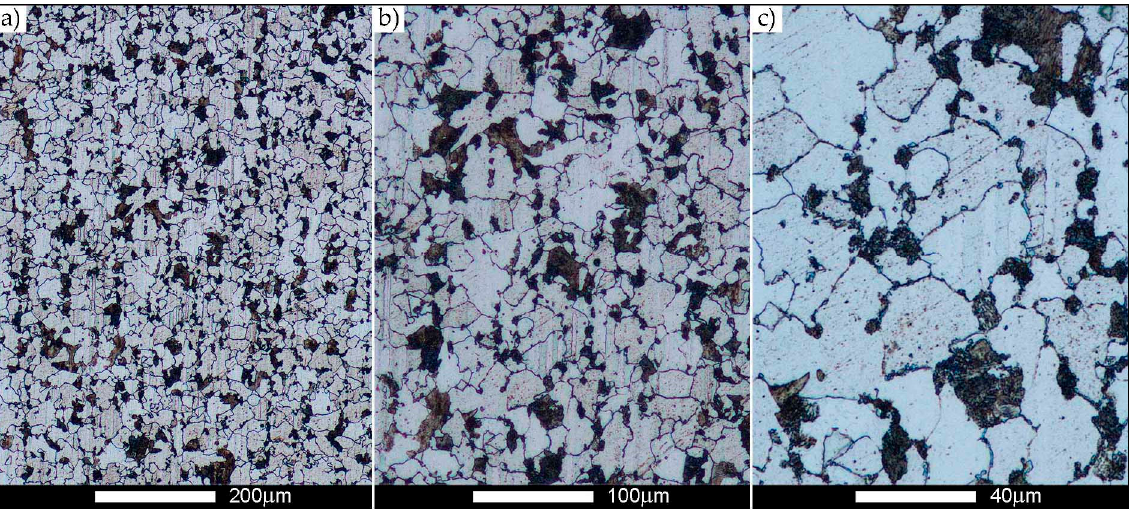
Figure 24. Welded joint microstructure of Hardox 450 steel with revealed grain boundaries of prior austenite, austenitised at 900 °C—BM zone shown in Figure 2. ( a ) 100×; ( b ) 200×; ( c ) 500×.